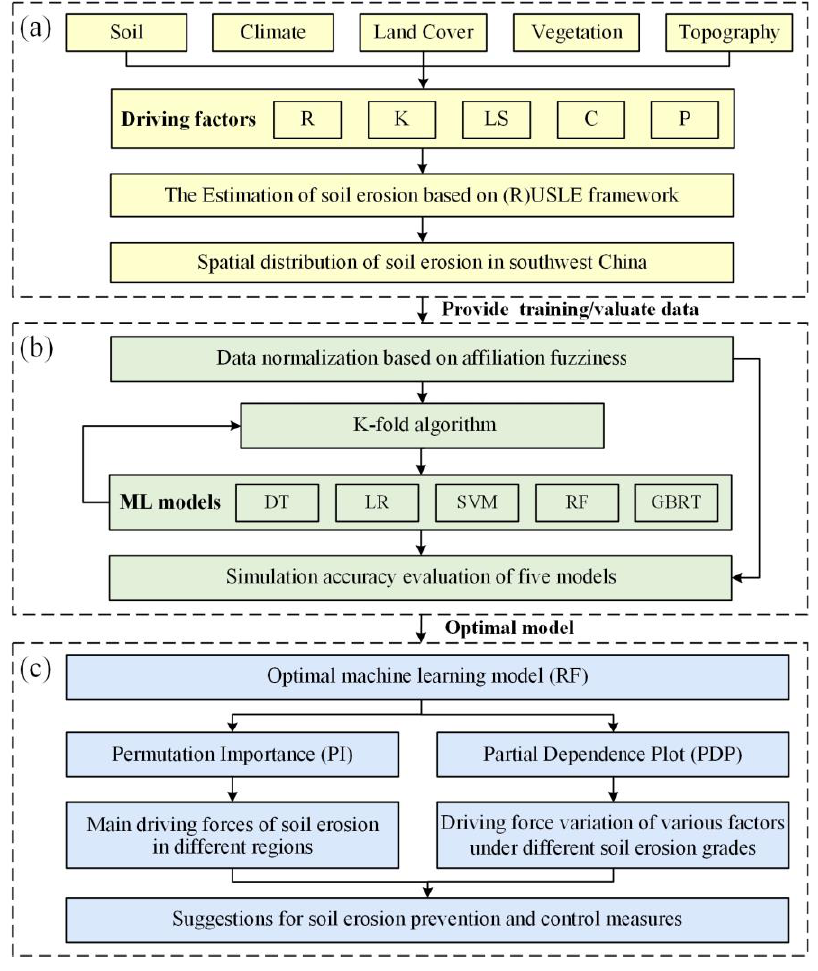
Figure 3. Technical flowchart. ( a ) Soil erosion estimation of southeast China based on (R)USLE framework; ( b ) Soil erosion simulation using ML models; ( c ) Driving force analysis of soil erosion by using RF model. R: Rainfall Erosivity Factor; K: Soil Erodibility Factor; LS: Slope Length and Steepness Factors; C: Cover-Management Factor; P: Support Practice Factor; ML: Machine Learning; DT: Decision Tree; LR: Logistics Regression; SVM: Support Vector Machine; RF: Random Forest; GBRT: Gradient Boosting Regression Tree.